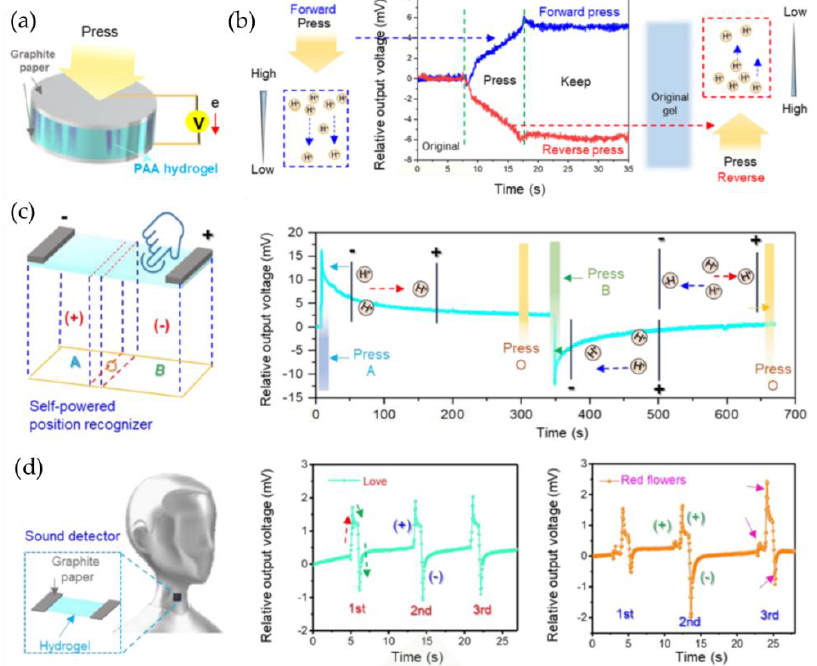
Figure 7. ( a ) Schematic diagram of PAA hydrogel-based sensor. ( b ) The working principle of PAA hydrogel converting mechanical energy into electrical energy. ( c ) A schematic diagram of the self- powered position recognizer and the corresponding variations in the output voltage of the detector, in response to pressing at different locations on the sensor. ( d ) Application of the PAA hydrogel-based sensor as a sound detector. (Reprinted with permission from [78] .)